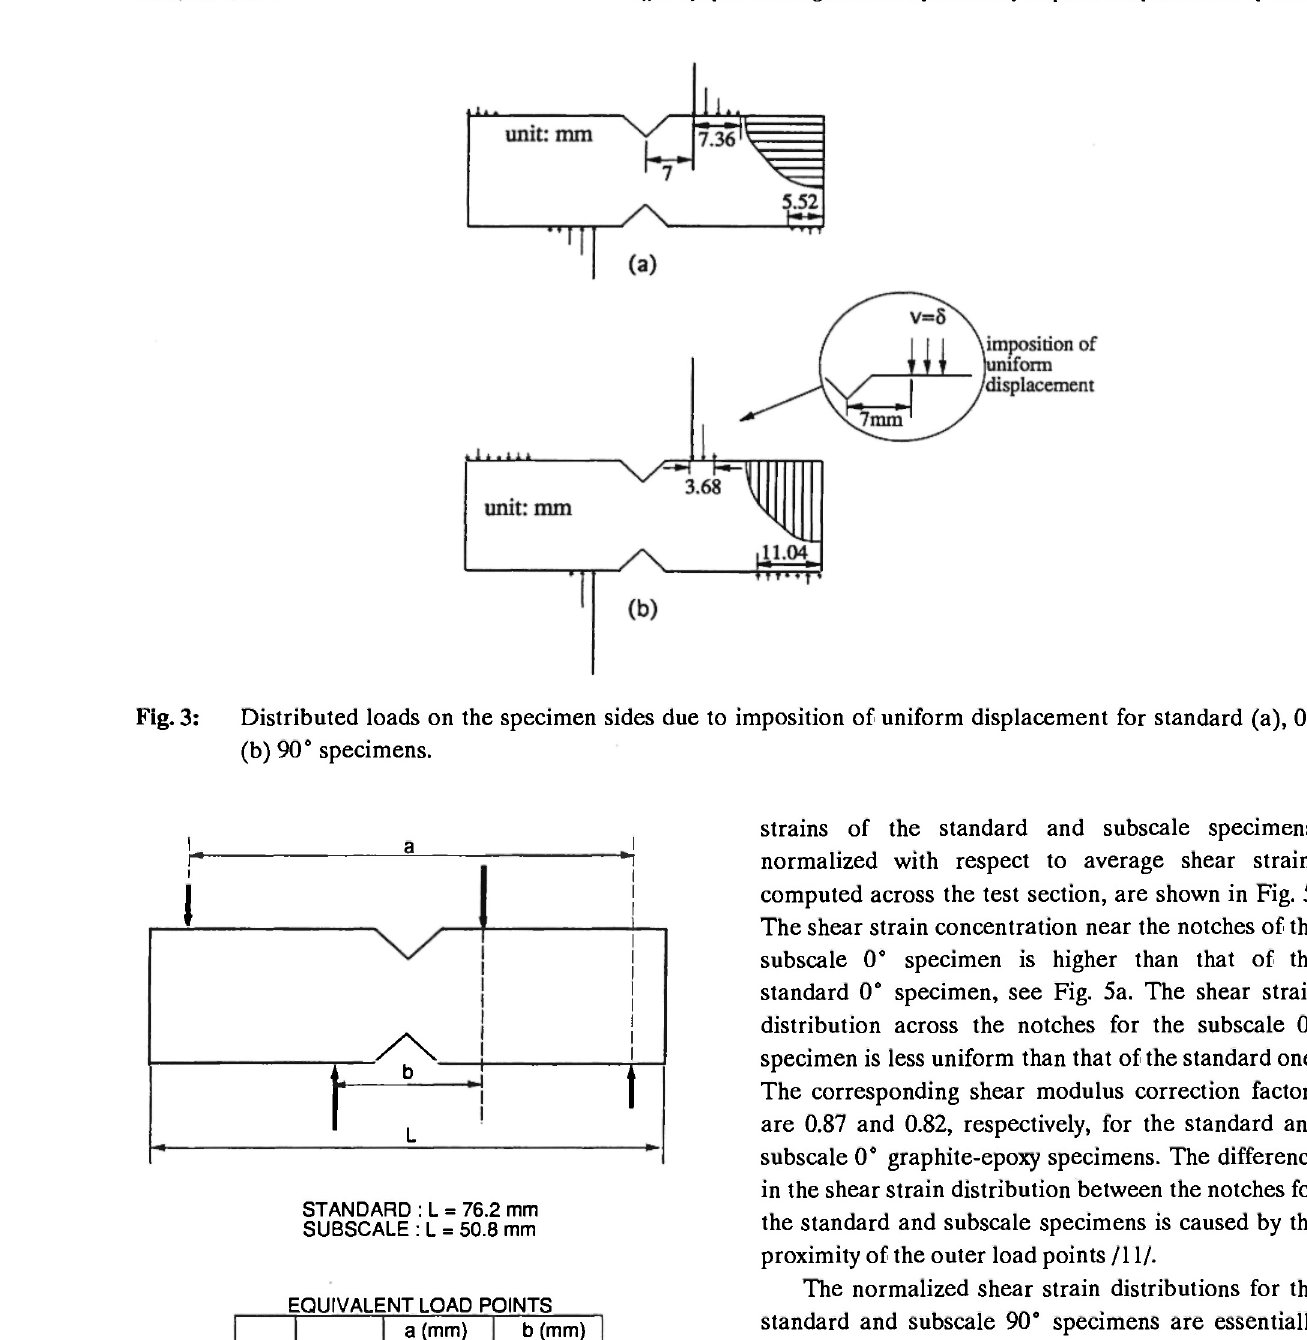
Fig. 4: Equivalent concentrated load points for standard and subscale 0° and 90° specimens. Strain contours in the test section: Figs. 6a and